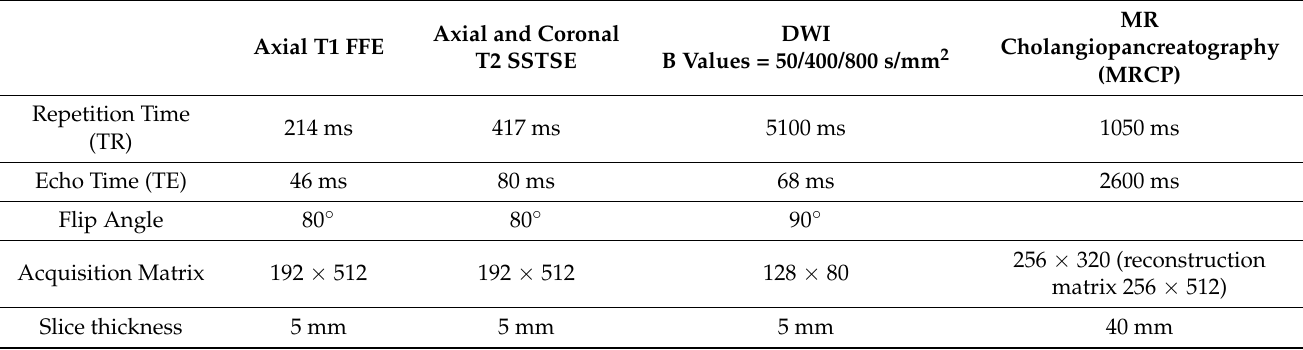
FFE = Fast-Field Echo Sequence. SSTSE = Single-Shot Turbo Spin Echo